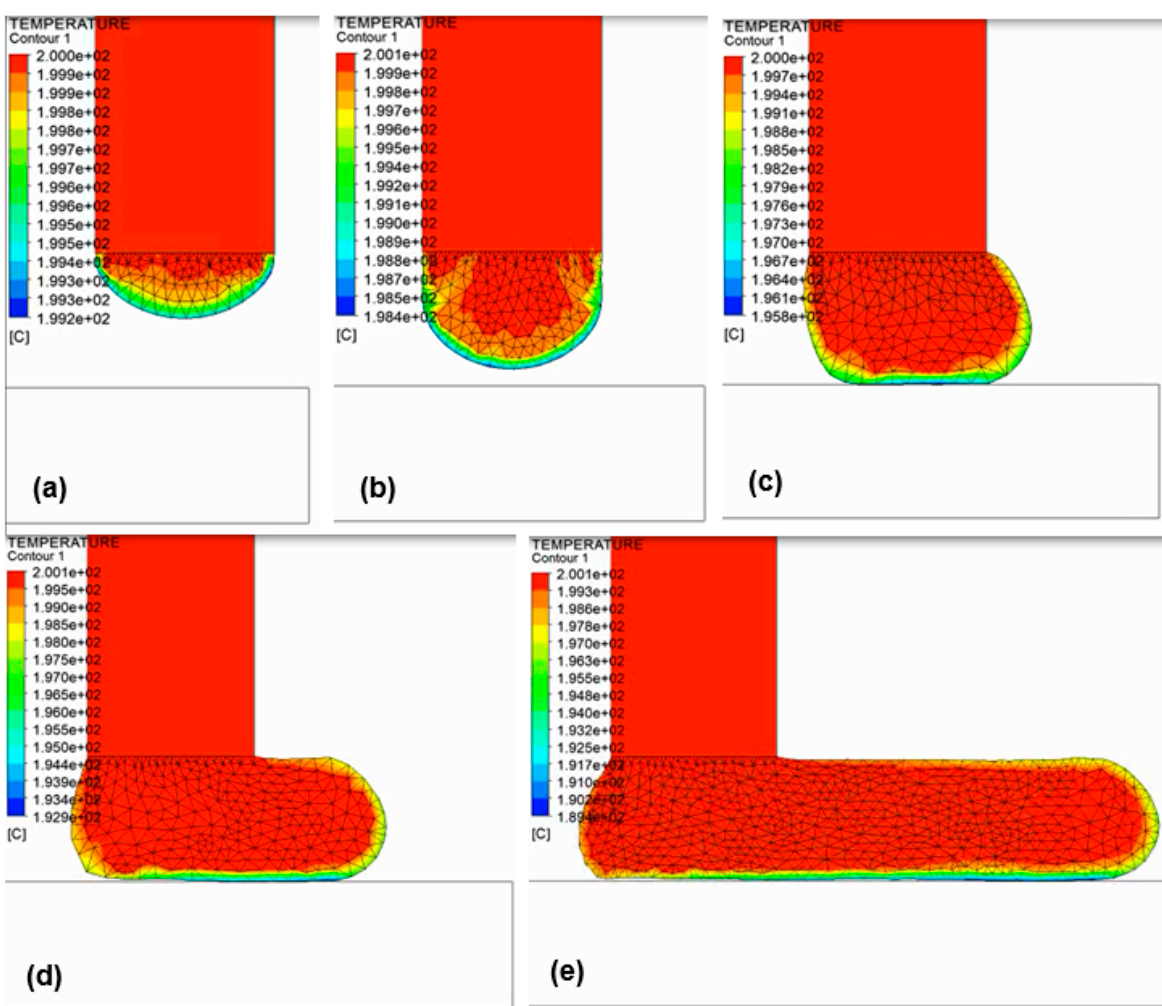
Figure 8. Snapshots of temperature contours during material deposition in large-scale AM. To account for the increase in material volume during extrusion, an adaptive remeshing scheme refines elements that have deformed significantly and become too stretched on the melt free surface.